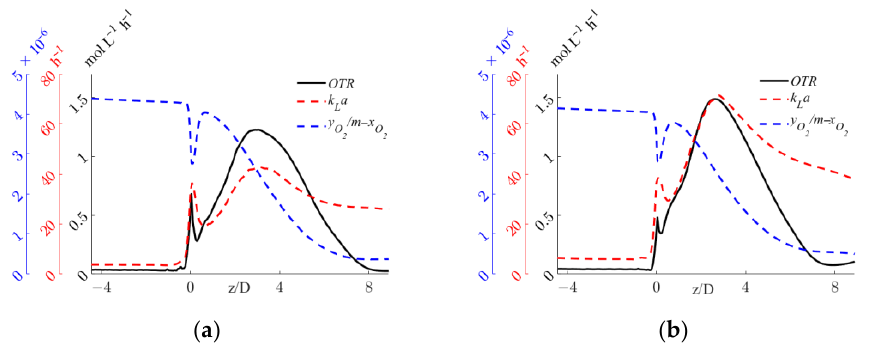
Figure 9. Axial profiles of OTR , k L a , and interphase mass transfer driving force, y O2 /m-x O2 , for the operative conditions considered: ( a ) Q L = 25 m 3 /h and Q G = 3.75 L/min; ( b ) Q L = 30 m 3 /h and Q G = 7.5 L/min. The initial and final part of the pipe are omitted to improve readability.